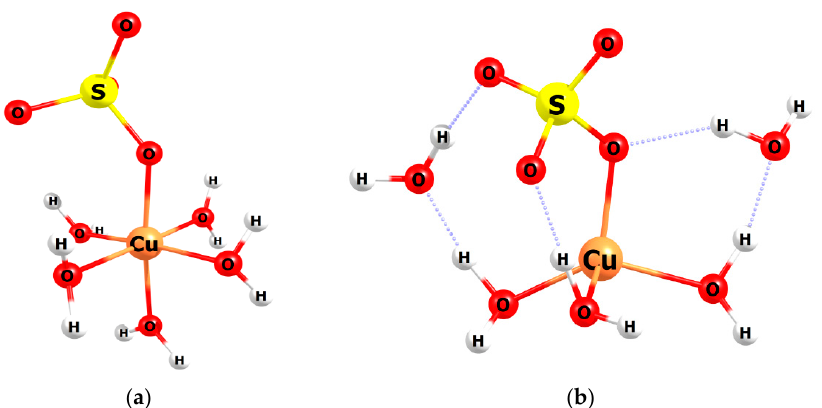
Figure 7. Structures of the CuSO 4 ·5H 2 O with the metal atom in the configuration: ( a ) octahedral; ( b ) tetrahedral. ( b ) tetrahedral.